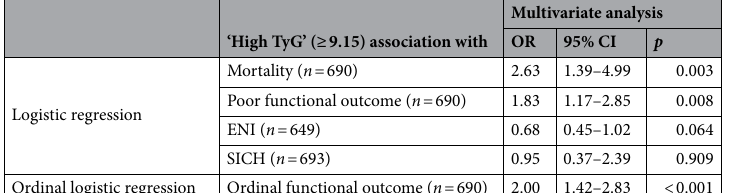
‘High TyG’ (≥ 9.15) association